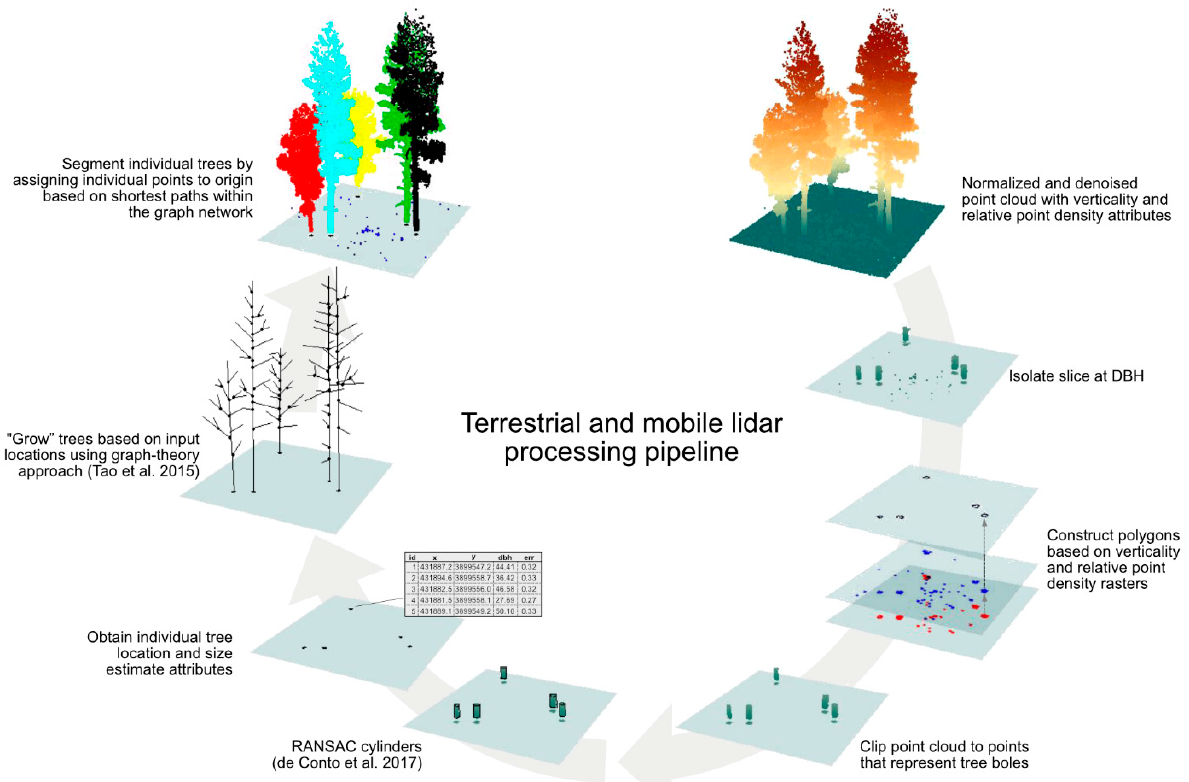
Figure 3. Pipeline of analysis approach utilized in this study.